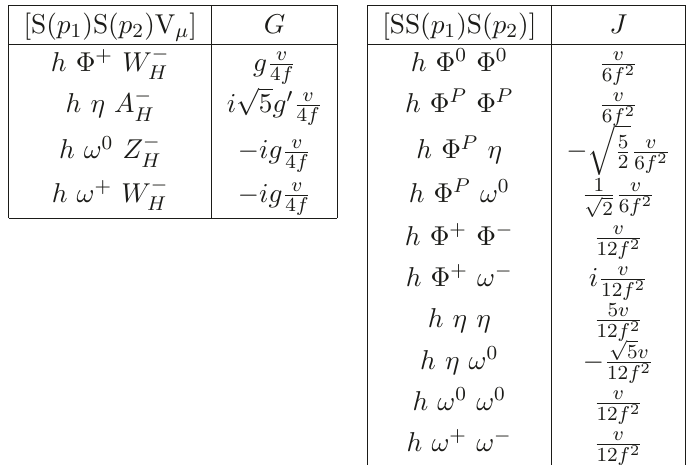
2 ( v ). Other combinations f 2 O